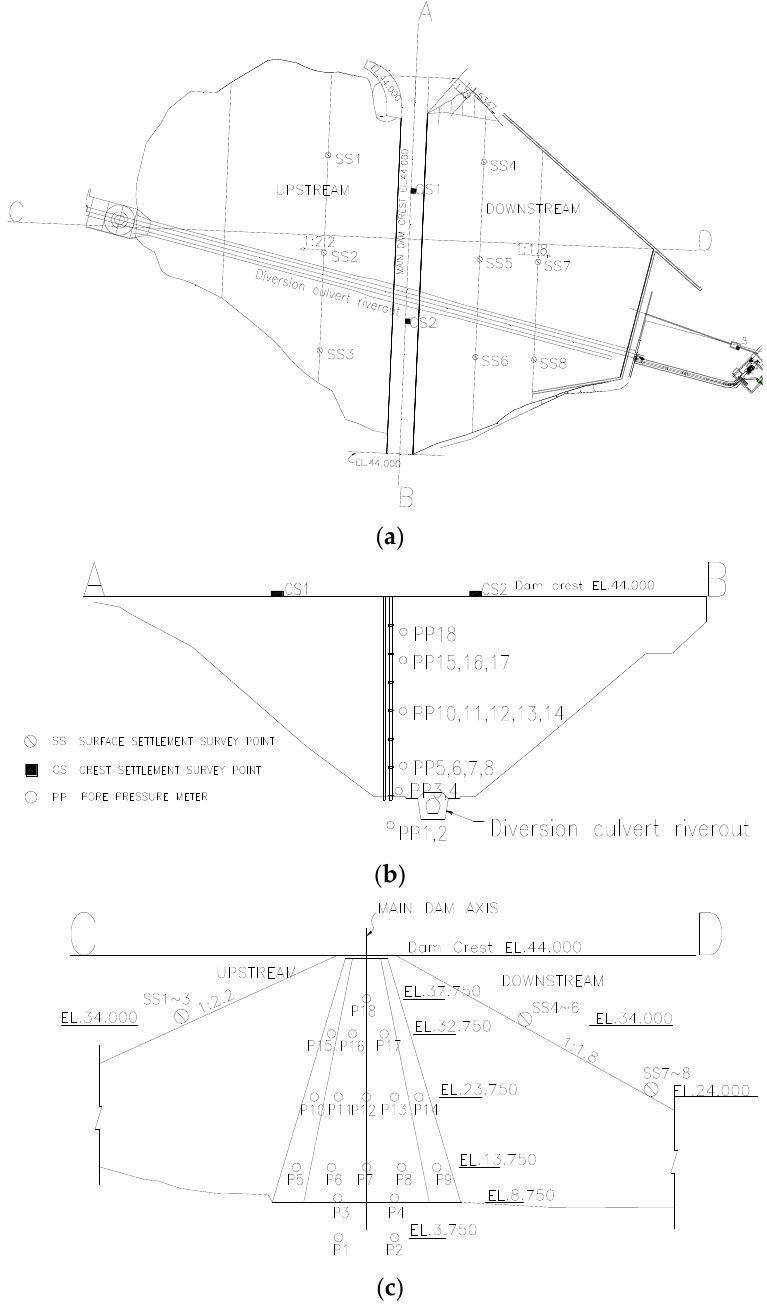
Figure 2. Location of porewater pressure transducers: ( a ) on the floor plan; ( b ) on the cross-section (A – B); ( c ) on the cross-section (C – D).